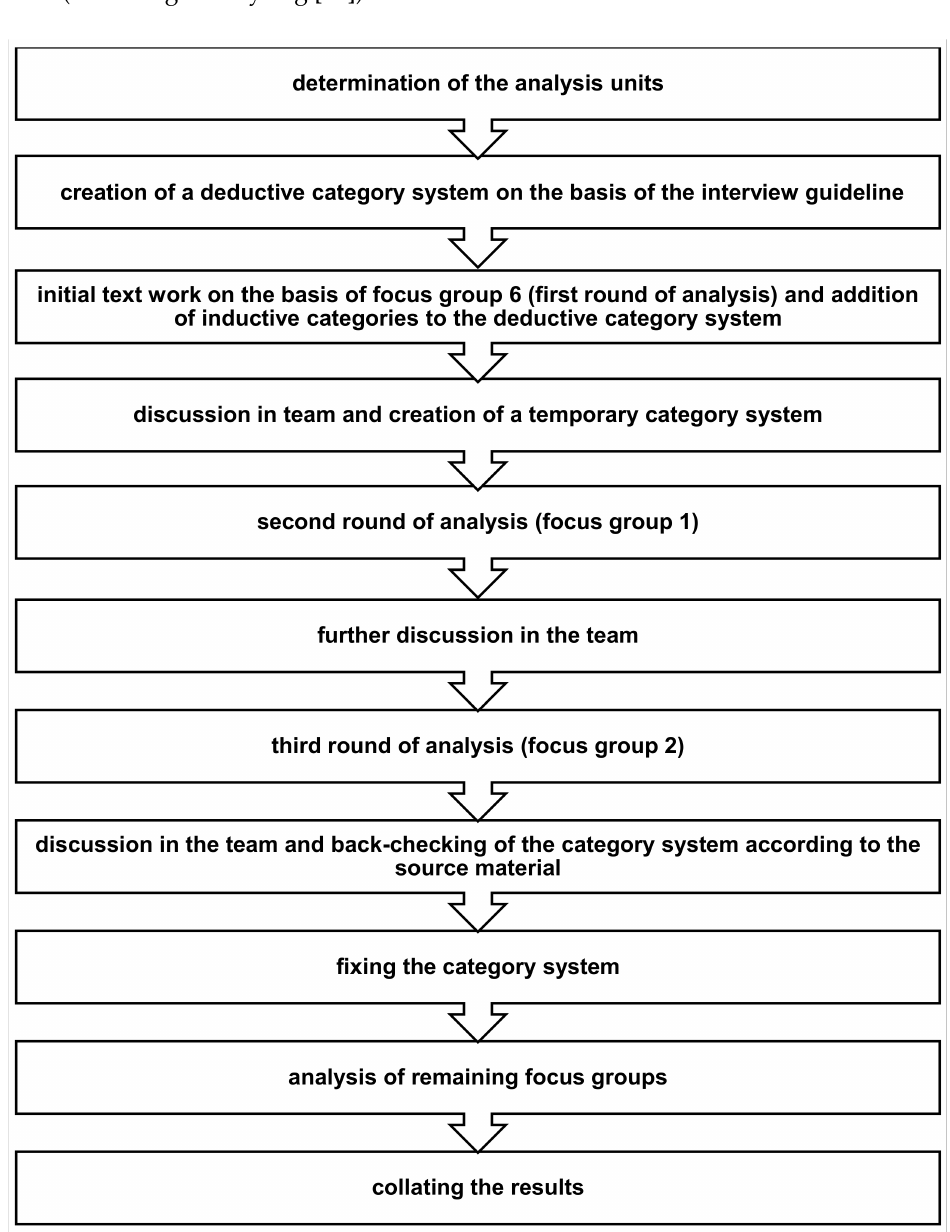
Figure A1. Illustration of the process of qualitative content analysis (according to Mayring [40]). This figure demonstrates the process of qualitative content analysis as used in this study. It originates from the suggested qualitative content analysis by Mayring [40]. Recreated by the